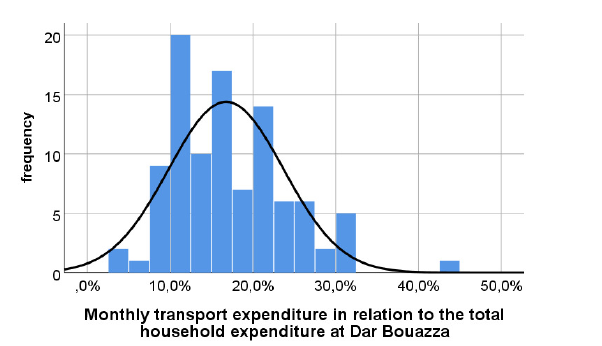
Figure 5 : Transport cost compared to the total monthly expenditure of households